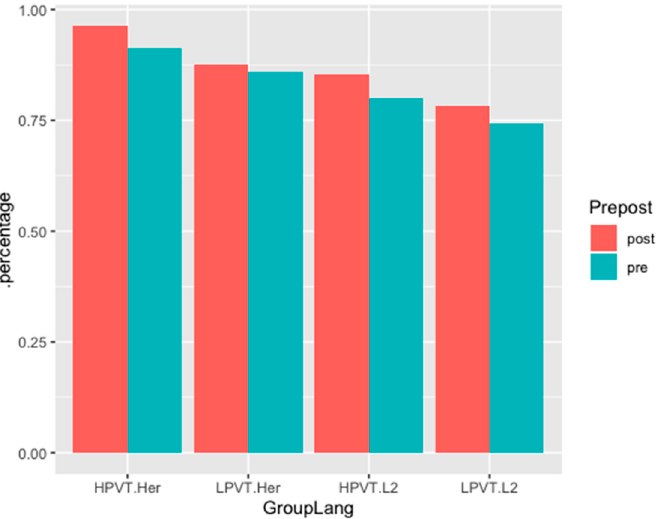
Figure 2. Proportion of correct answers by group and native language in the pre-test and post-test. A mixed effects logistic regression was run on the effect on the responses for the task with the following fixed factors: an interaction factor between type of instruction and learner profile (with the levels HPVT-Her, HPVT-L2, LPVT-Her, LPVT-L2), testing time (pre-test vs. post-test), and the position of the segment in the word (penultimate syllable vs. ultimate syllable). The interaction of these two factors was also analyzed to see whether there was a difference across groups from the pre-test to the post-test. The HPVT-Heritage group, the post-test, and the initial position of the segment were the reference levels.